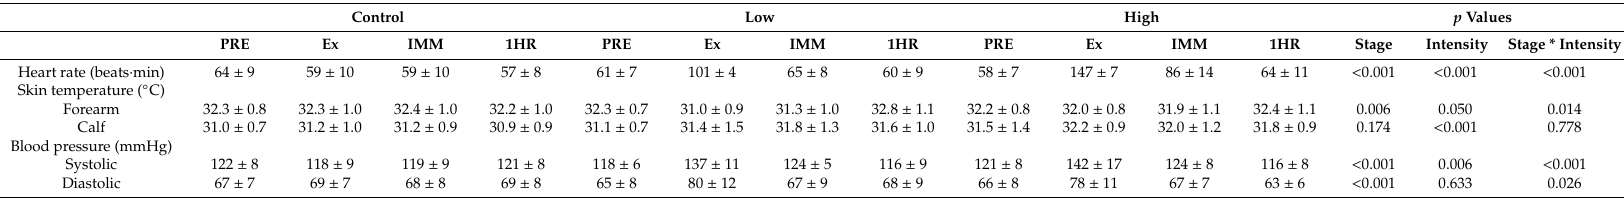
Table 1. Cardiovascular and local skin temperature responses before (PRE), during (Ex), and immediately (IMM) and 1 hr (1HR) after 30 min of low and high intensity exercise and control rest. Data are mean ± 1